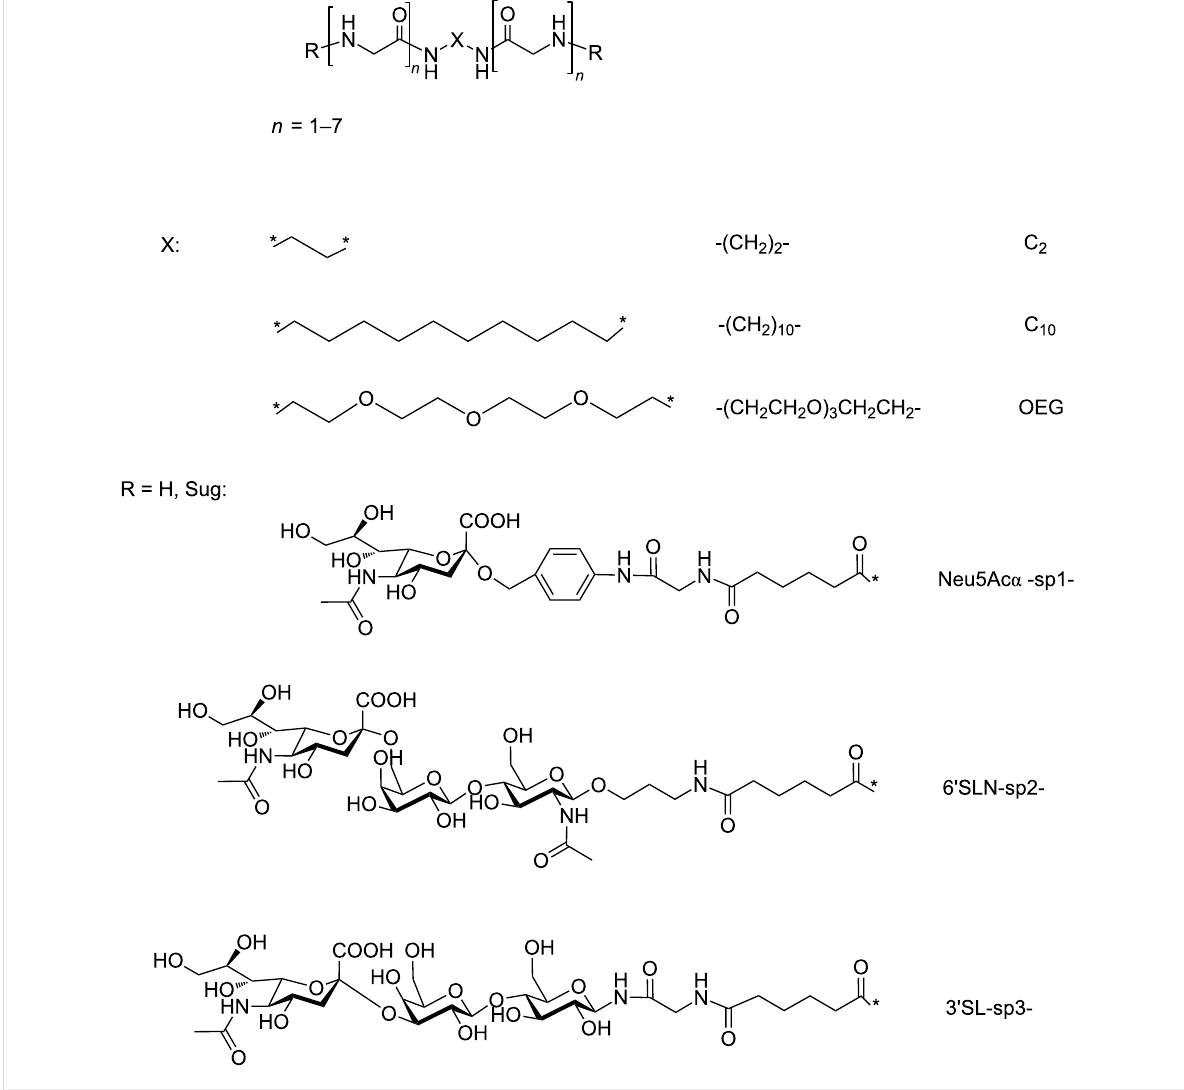
Figure 1: The structure of biantennary oligoglycines and their glyco derivatives (sp = spacer group).